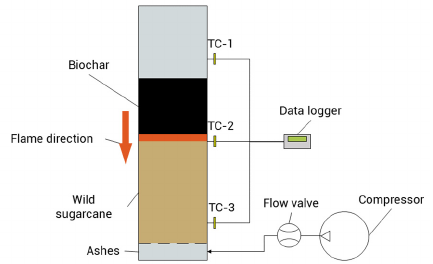
Figure 1. Schematic diagram of wild sugarcane biochar production in a top-lit updraft gasifier. TC-1, TC2, and TC-3 represent the 3 thermocouples connected to the data logger.